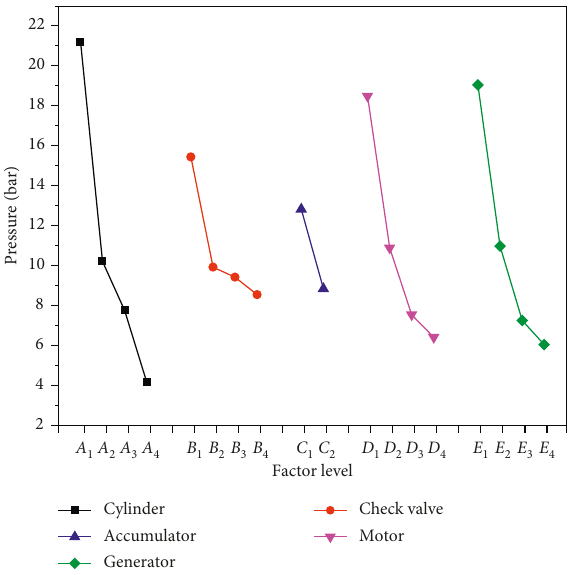
Figure 9: The index level of regeneration efficiency at different